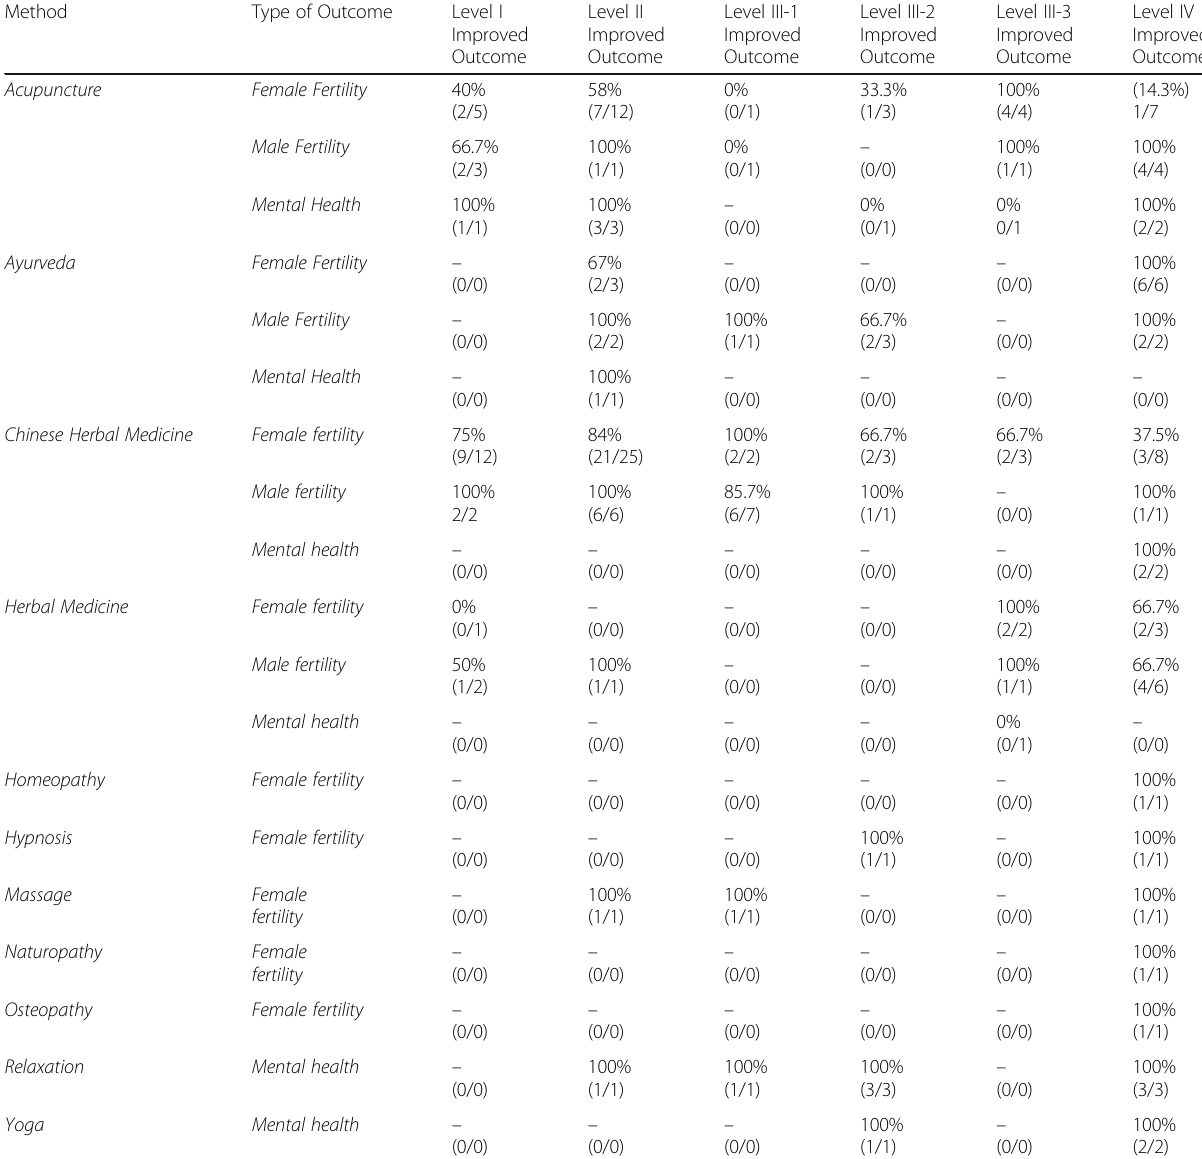
Table 5 Evidence for Positive Outcomes